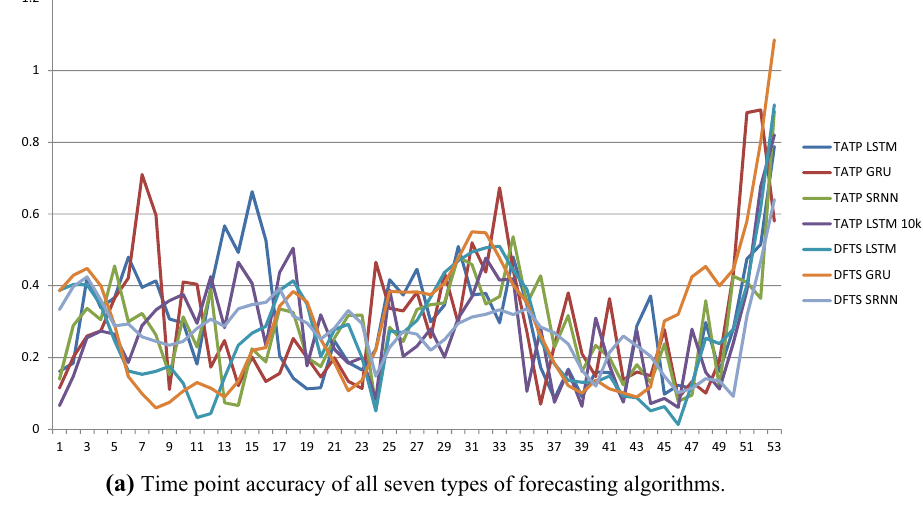
(a) Time point accuracy of all seven types of forecasting algorithms.